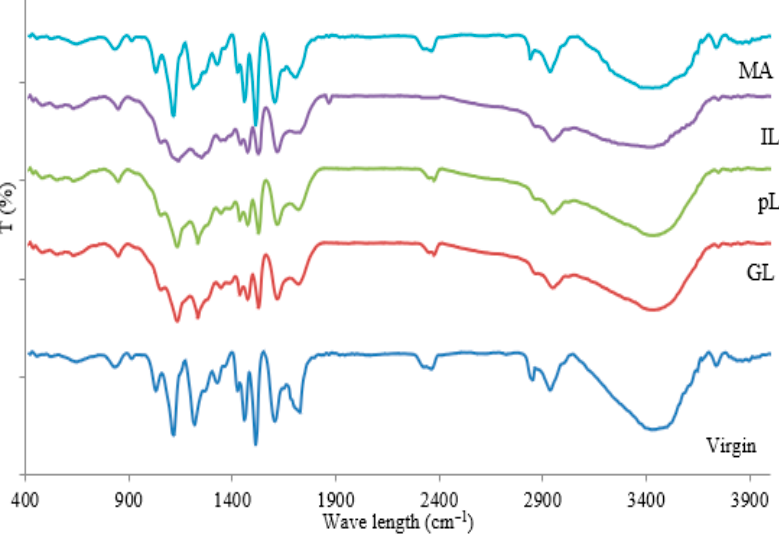
Figure 2. FTIR analysis of pure and modified lignin.